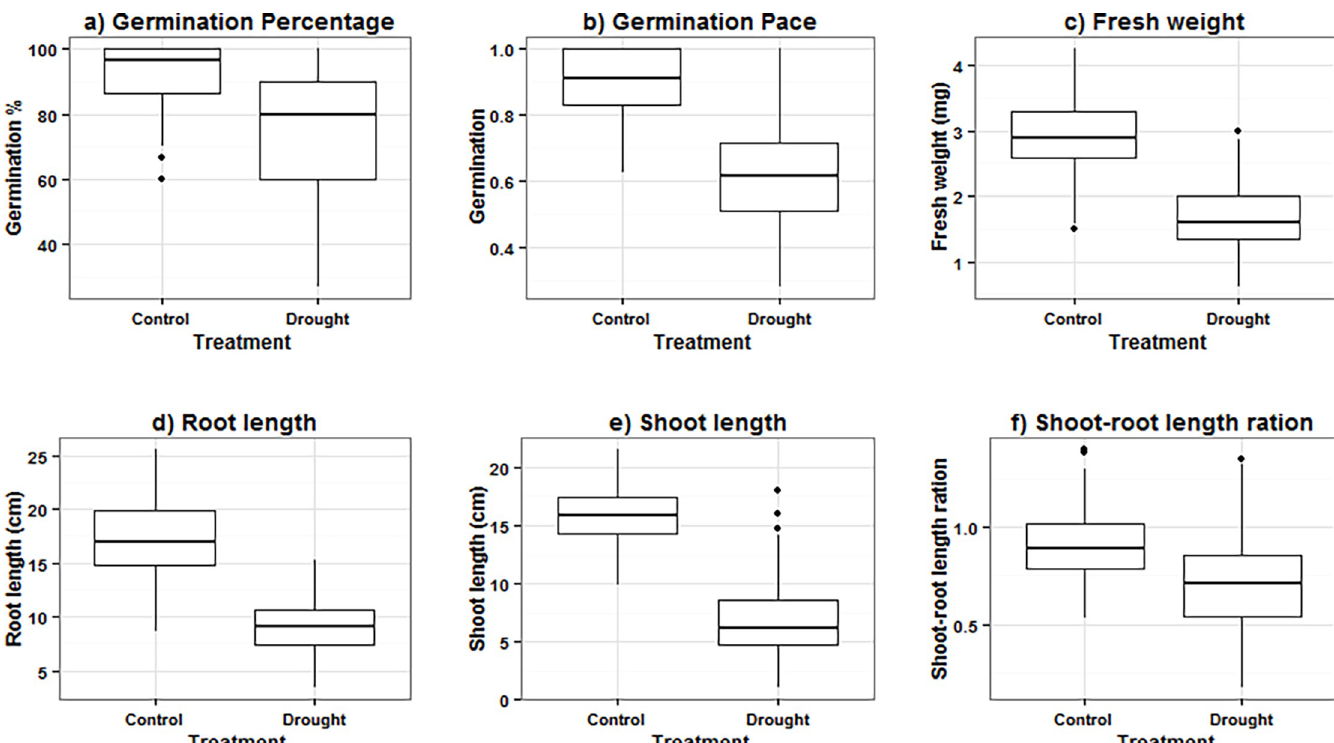
Fig 1. Boxplot analysis of variation of the traits; a) Germination percentage, b) Germination pace, c) Fresh weight, d) Root length, e) Shoot length and f) Shoot-root length ration in barley genotypes under control and drought stress (20%